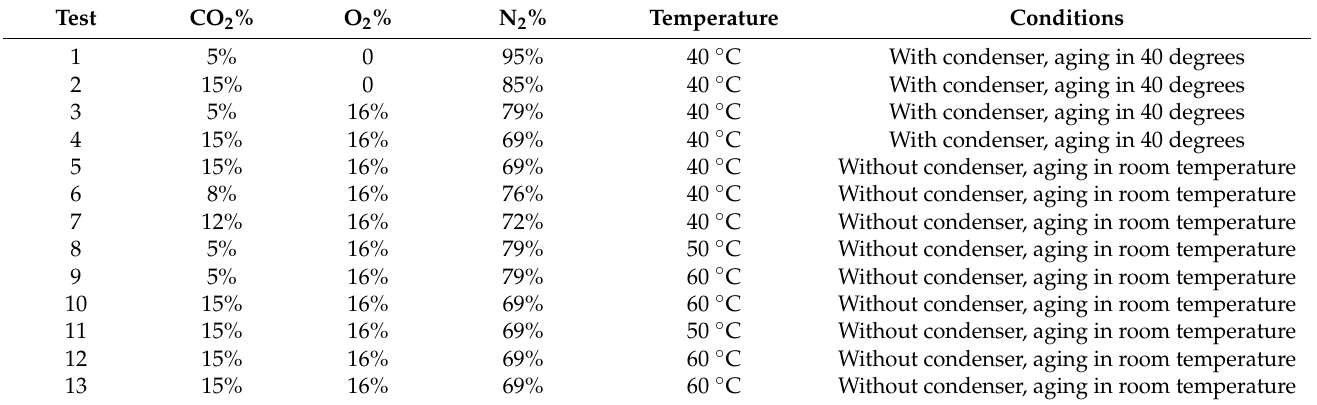
Table 3. Experimental plan: Gas composition and temperatures.